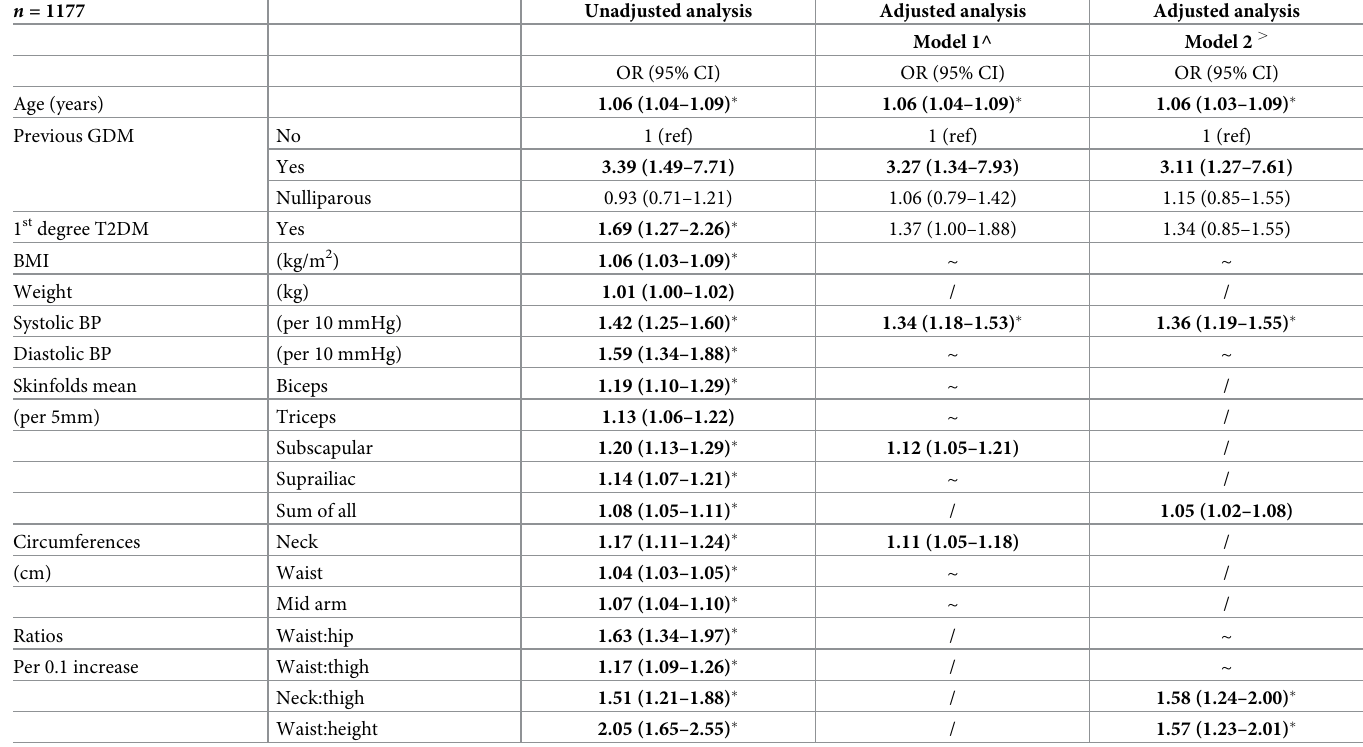
Table 4. Clinical history, and clinical and anthropometric variables measured at 17 +0 weeks’ (mean) gestation associated with later development of GDM; unad- justed and multiple regression analyses. n =